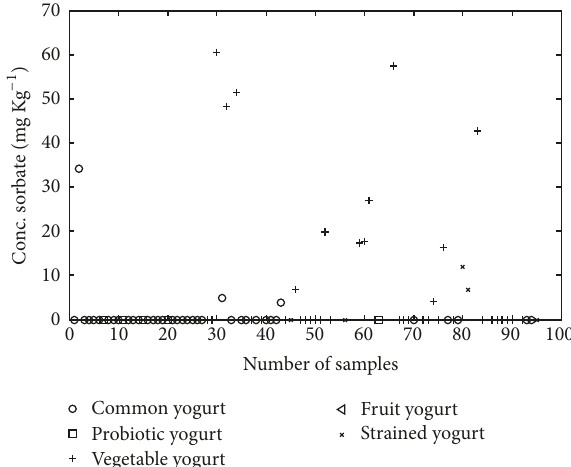
Figure 5: Illustration of the benzoate content and pH in each yogurt sample. The violet rectangle shows the permitted range for concentration of benzoate and the suitable pH for the activation of it.